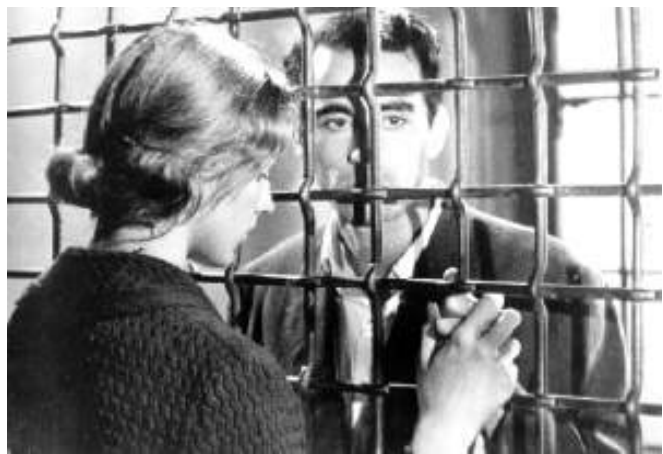
Figure 12. Proximity in Pickpocket .